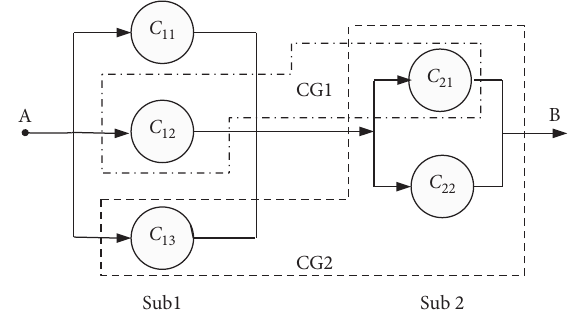
Figure 1: Series-parallel structure of